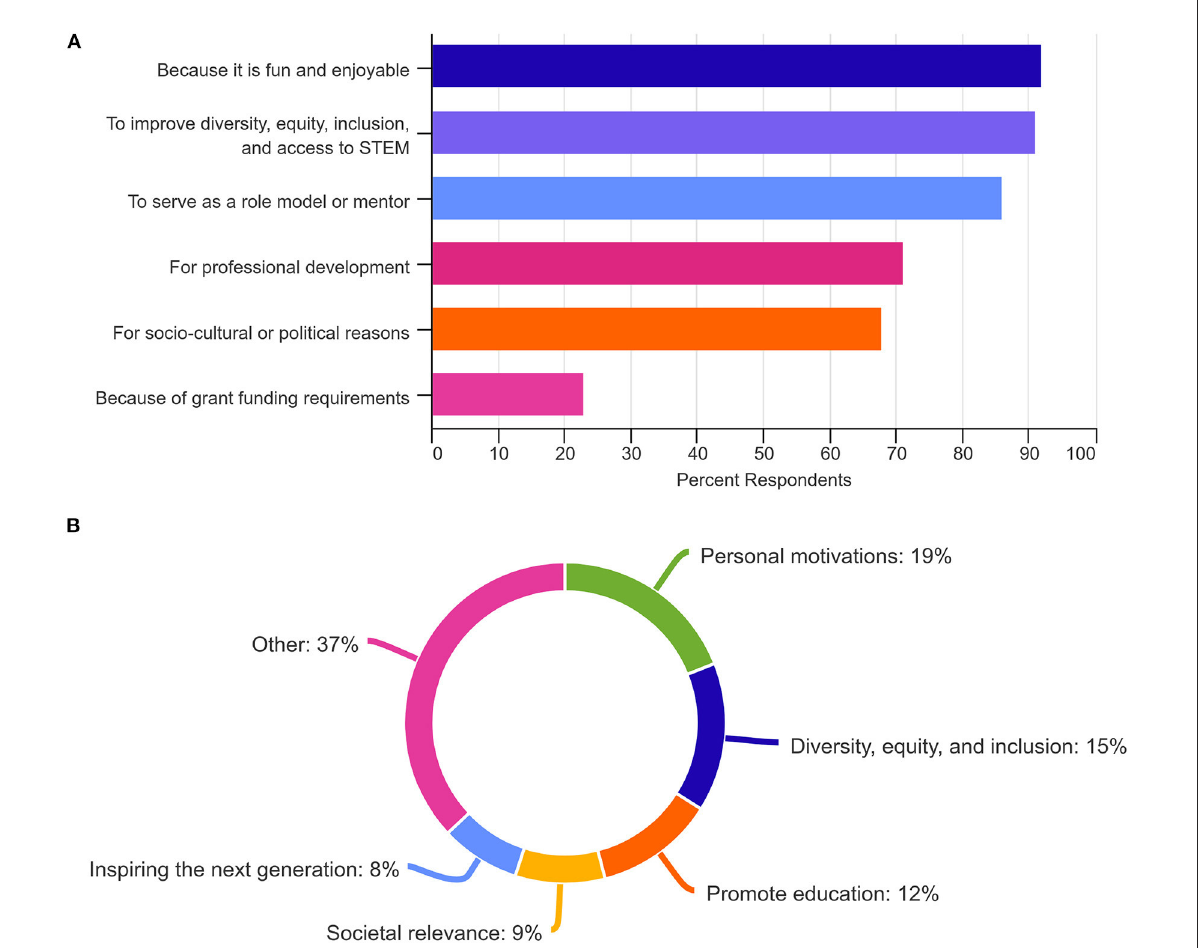
FIGURE5 Respondents’ motivations for participating in science outreach. (A) Percentage of respondents (n = 488) who indicated that they participate in science outreach for various reasons. (B) Percentage of codes ( n = 388) associated with respondents’ qualitative responses to the question, “I participate in science outreach